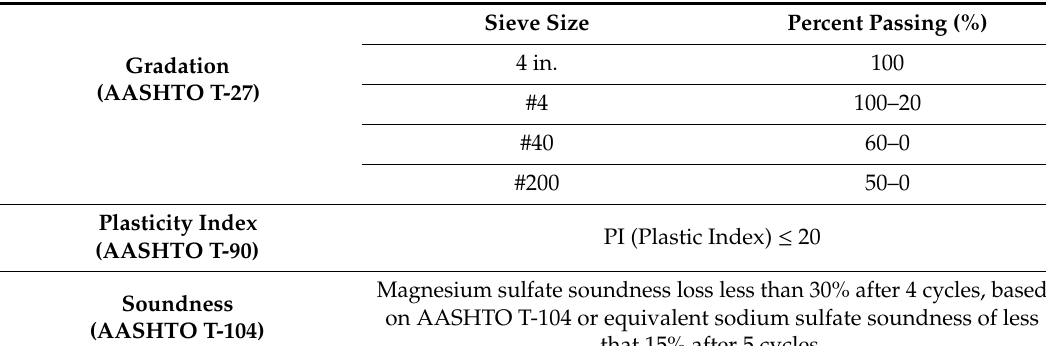
Table 3. Granular Reinforced Fill Recommendations